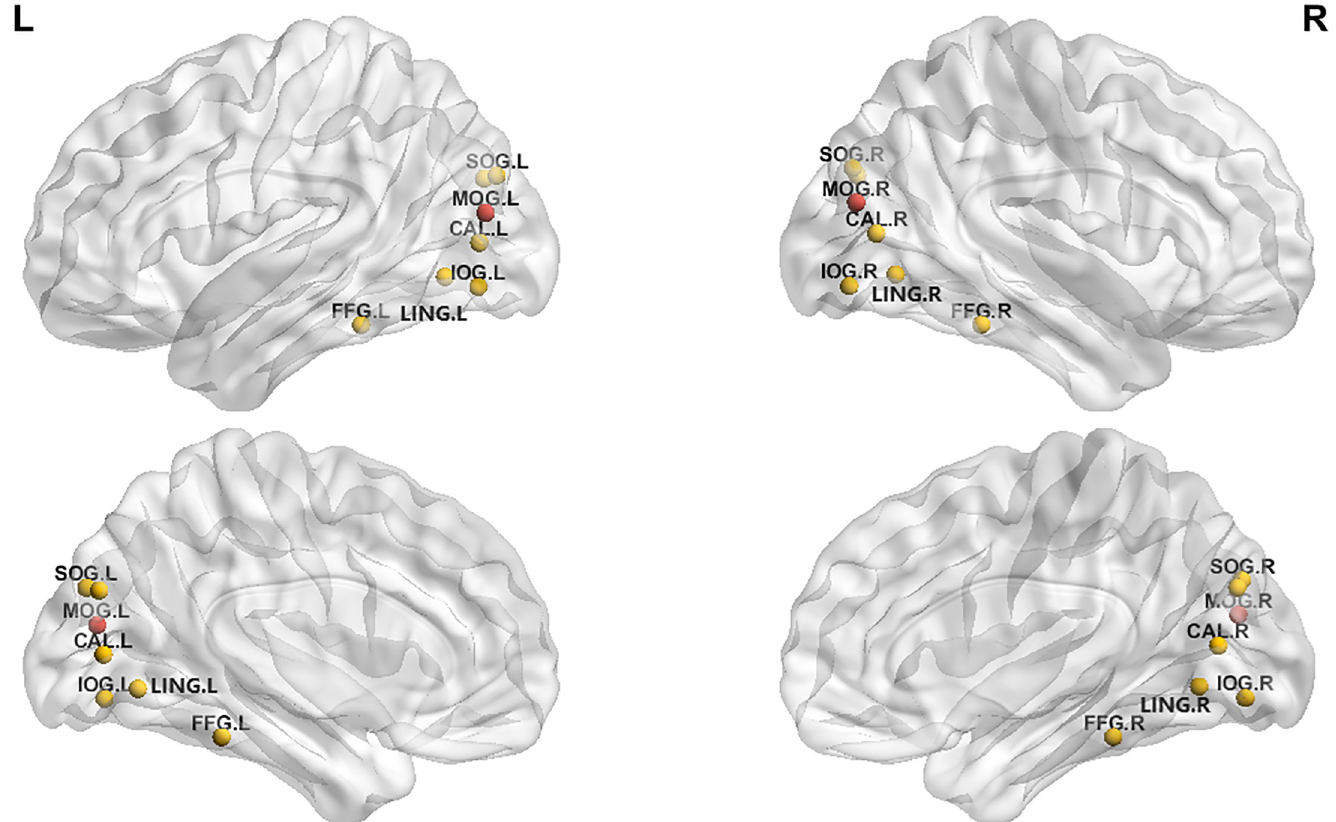
Fig 2. Bilateral middle occipital region showed higher E loc in the CCH group than in the control group (red) in Module I, with 1000 permutations (p < .05). Note: 1. Calcarine_L; 2. Calcarine_R; 3. Cuneus_L; 4. Cuneus_R; 5. Lingual_L; 6. Lingual_R; 7. Occipital_Sup_L; 8. Occipital_Sup_R; 9. Occipital_Mid_L; 10. Occipital_Mid_R; 11. Occipital_Inf_L; 12. Occipital_Inf_R; 13. Fusiform_L; 14. Fusiform_R.